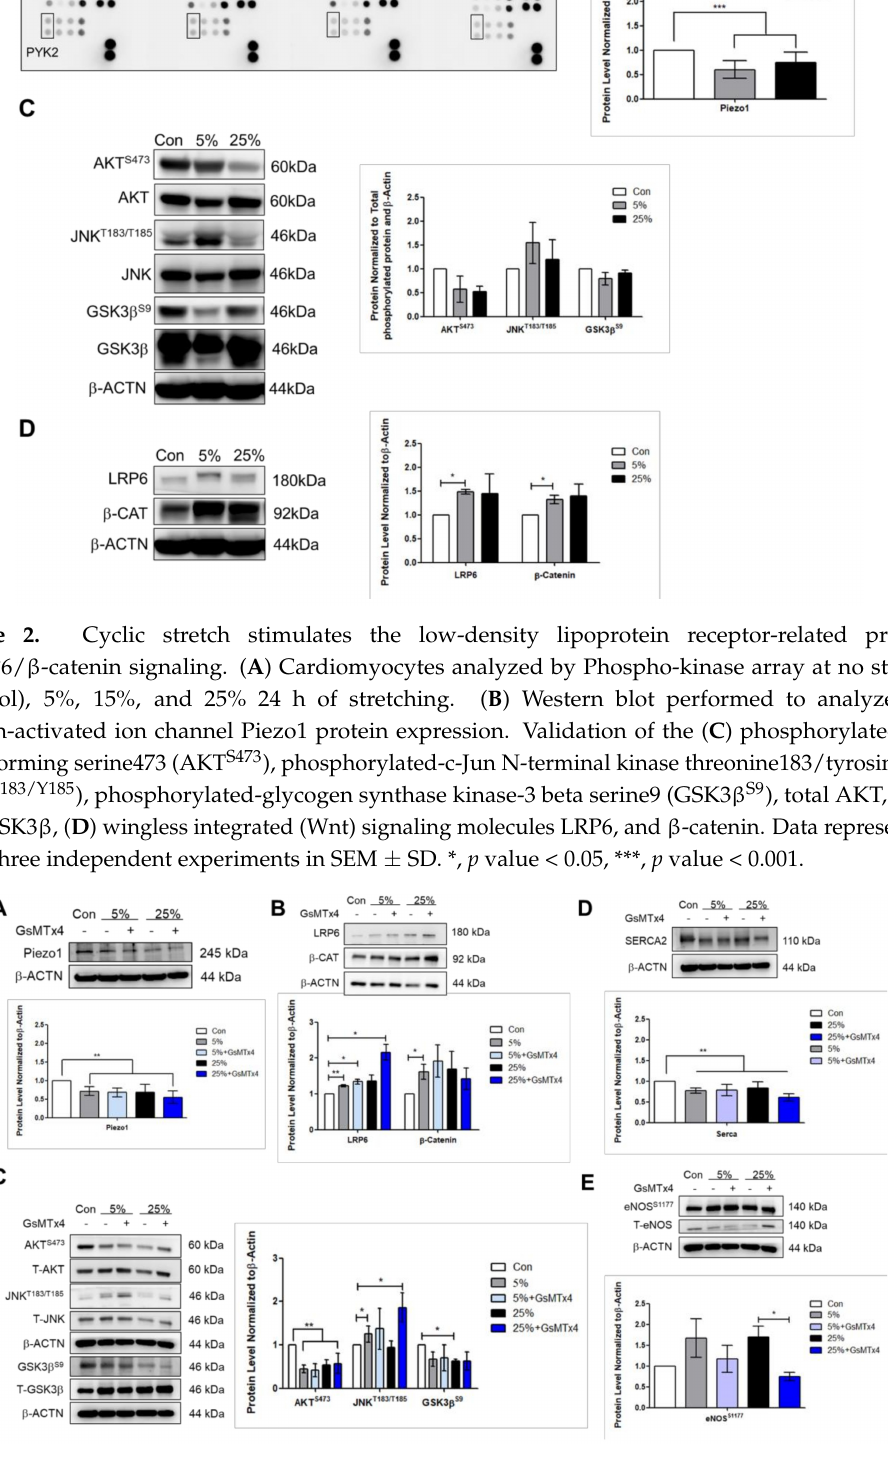
Figure 3. Aggressive mechanical stimulation further activates the LRP6/ β -catenin signaling when Piezo1 was inhibited. Western blot showing the protein expressions for ( A ) Piezo1, ( B ) LRP6, and β -catenin, ( C ) phosphorylated AKT S473 , JNK T183/Y185 , GSK3 β S9 , and total AKT, JNK, and GSK3 β